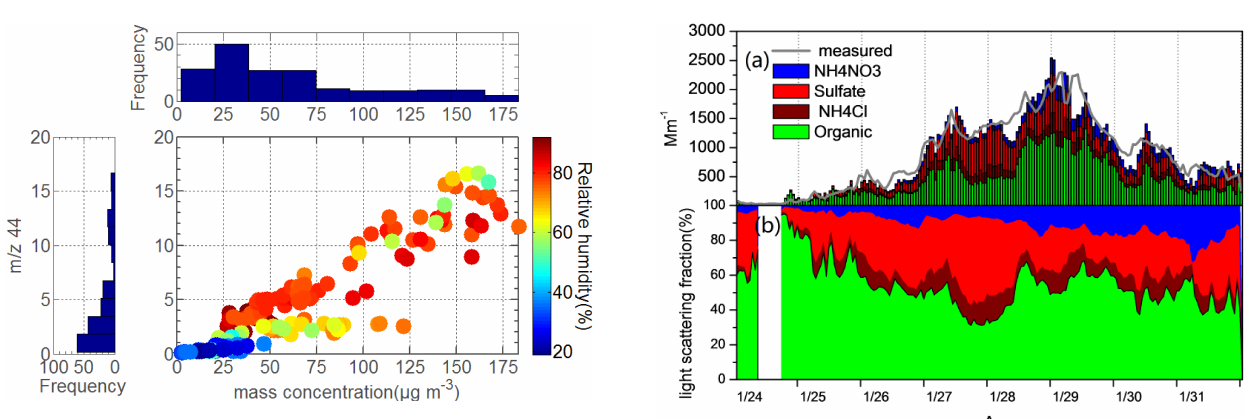
Figure 11. Time series of (a) apportioned light-scattering co- efficients of each aerosol component compared with measured (b) light-scattering fractions of each aerosol